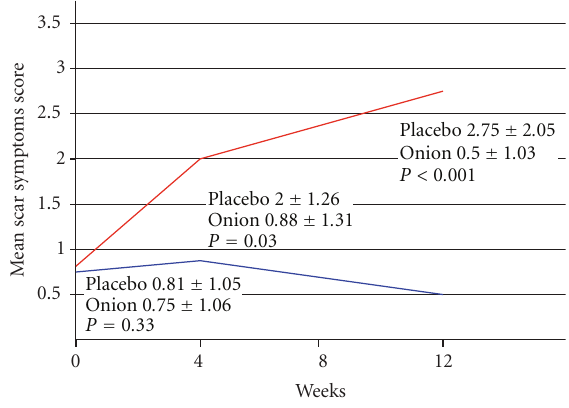
Figure 4: This figure compares mean scar symptoms score on the placebo and the treatment side. A statistically significant di ff erence was found at the 4th and 12th week follow-up. Red and blue line represents placebo and treatment side,